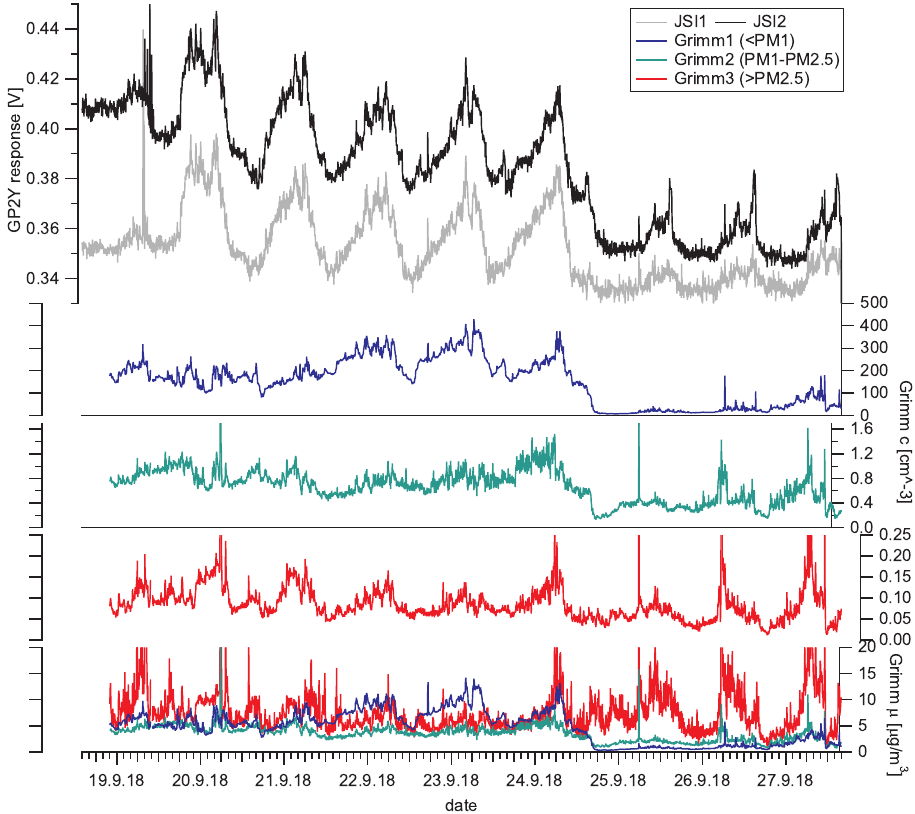
Figure 9. Comparison of Sharp low-cost sensors response and Grimm OPC particle number concentrations during one week of simultaneous measurement on a busy street in Cassino, Italy. Five-minute averages are shown. The two GP2Y sensors (top two curves) are denoted JSI1 and JSI2. Grimm 1, 2 and 3 labels correspond to PM diameter intervals d < 1 µ m, 1 µ m ≤ d ≤ 2.5 µ m and d > 2.5 µ m, respectively. In the middle three graphs, particle number concentrations are shown (in particles per cubic centimeter), and the bottom graph displays the corresponding measured mass concentrations (in micrograms per cubic meter).